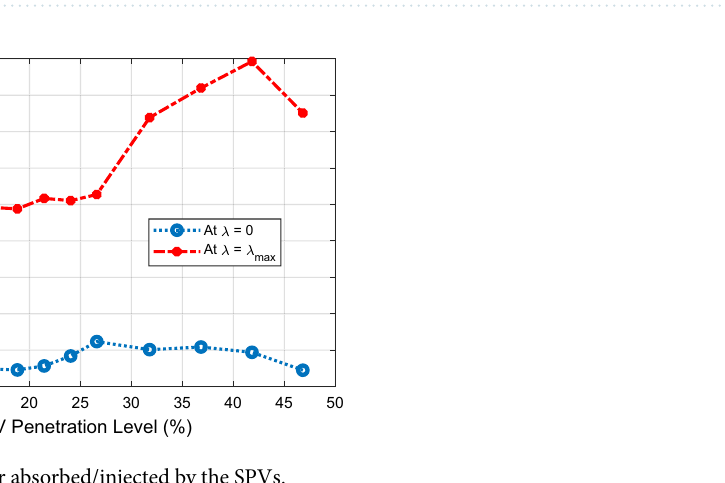
Figure 13. Reactive power absorbed/injected by the